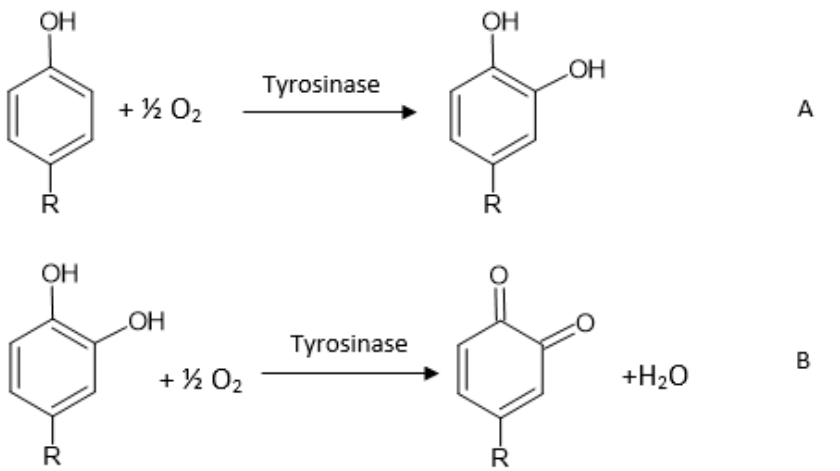
Figure 3. Tyrosinase reaction mechanism ( A = cresolasic activity; B = catecholasic activity).